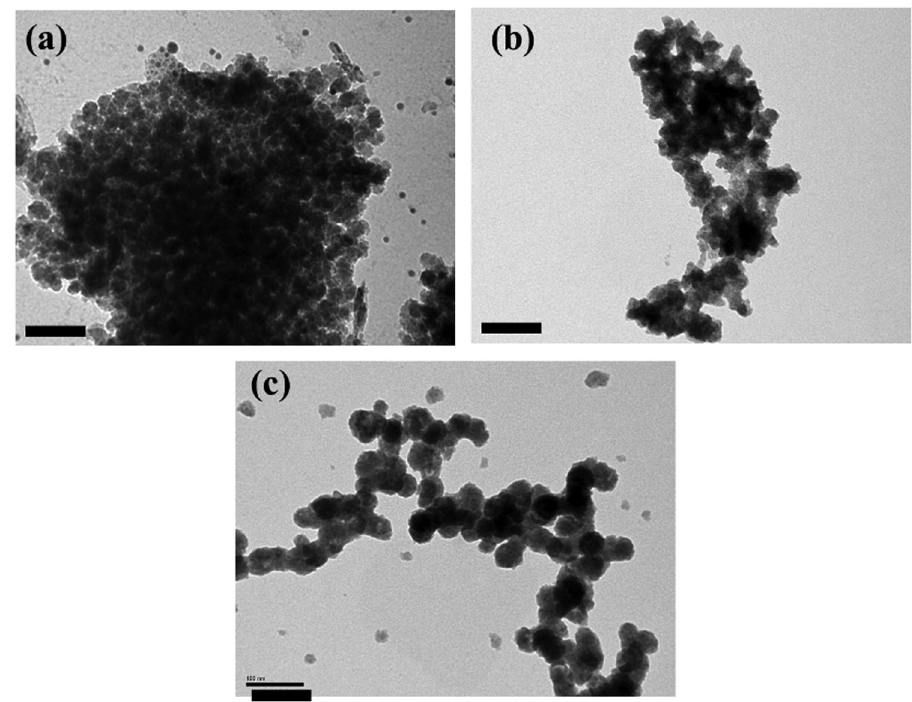
Figure 4: The TEM images of ZnSe:Mn ( 5% ) capped with Starch ( a ) , PEG ( b ) , and MPA ( c ) . Scale bar: 100